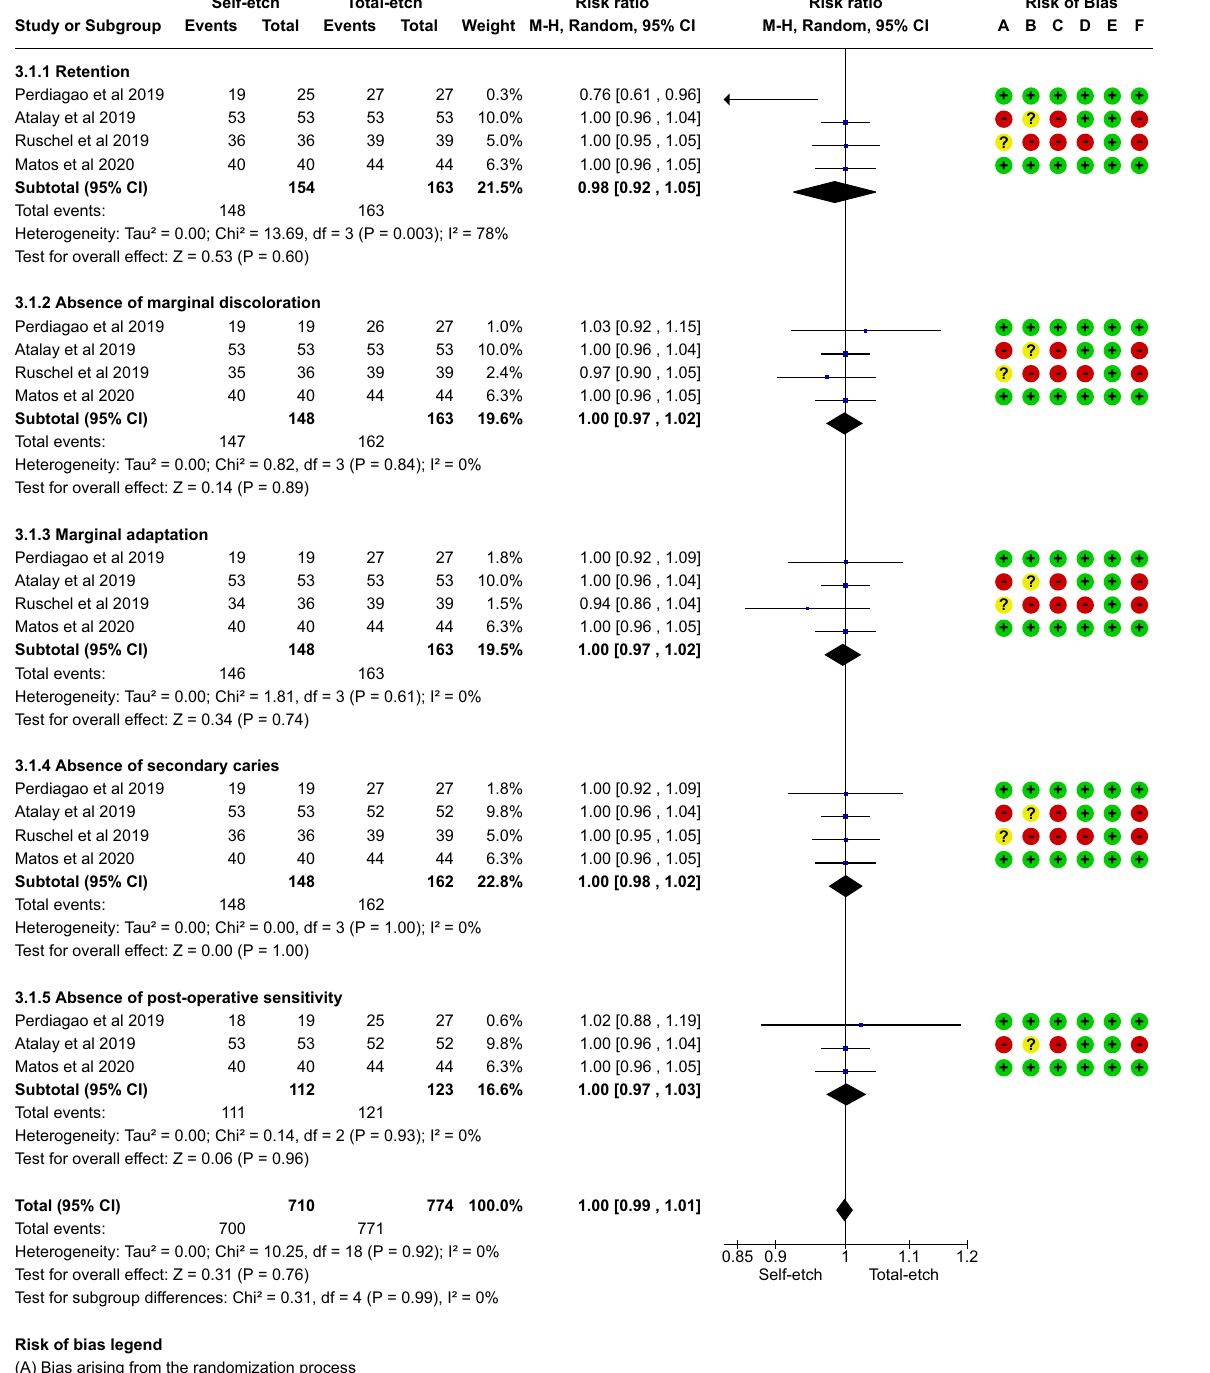
(B) Bias due to deviations from intended interventions: Comparison of self-etching and conventional at 36th month under USPHS criteria (C) Bias due to missing outcome data: Comparison of self-etching and conventional at 36th month under USPHS criteria (D) Bias in measurement of the outcome: Comparison of self-etching and conventional at 36th month under USPHS criteria (E) Bias in selection of the reported result: Comparison of self-etching and conventional at 36th month under USPHS criteria (F) Overall bias: Comparison of self-etching and conventional at 36th month under USPHS criteria Fig. 10 Forest plot representing the pooled events at 36 months using USPHS criteria. No signi fi cant difference observed between total etch and self-etch adhesive strategies for any of the